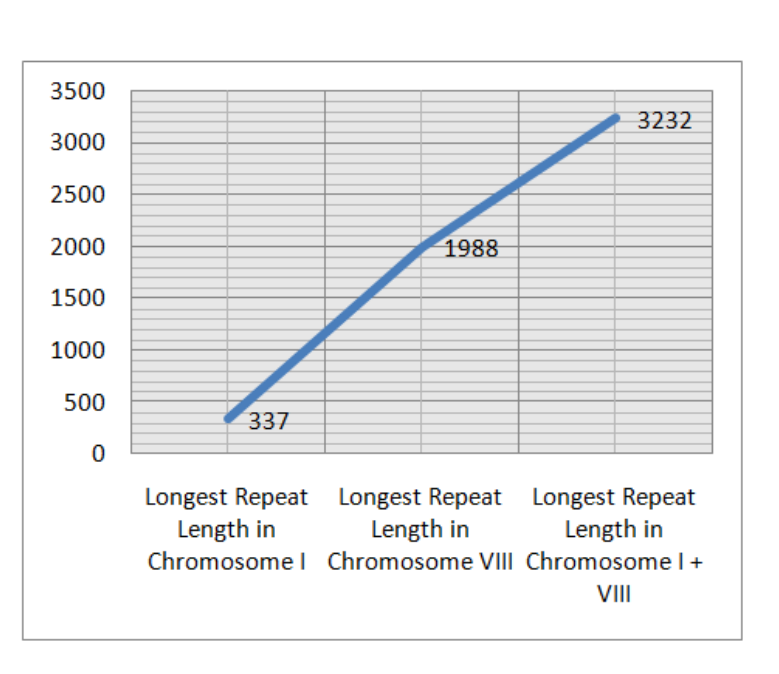
Figure 6. Enhancement in Repeat Length when Searching for Self- and Cross-Chromosomal